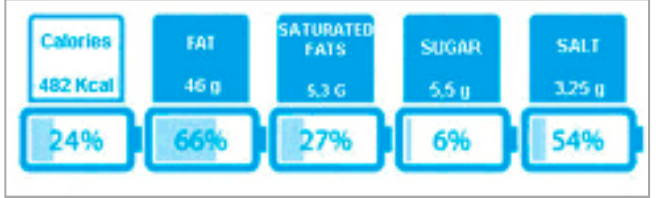
Figure A13. NutrInform Battery (Italy) is based on the Reference Intake Label (Figure A3) with an added battery symbol indicating the amounts of energy and nutrients in a single serving as a percentage of the daily intake. Directiveness: Non-Directive; Scope: All food; Gradation: Cardinal; Set of Reference: Across-Category; Sign: Numbers, ideograms.